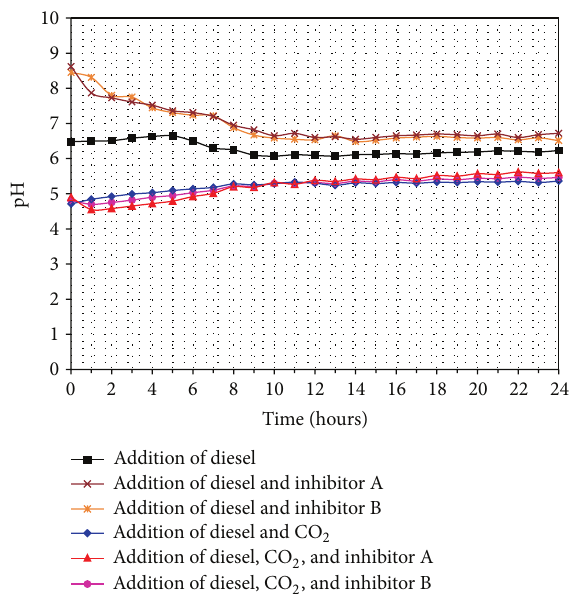
Figure 5: pH value as a function of the time during the corrosion